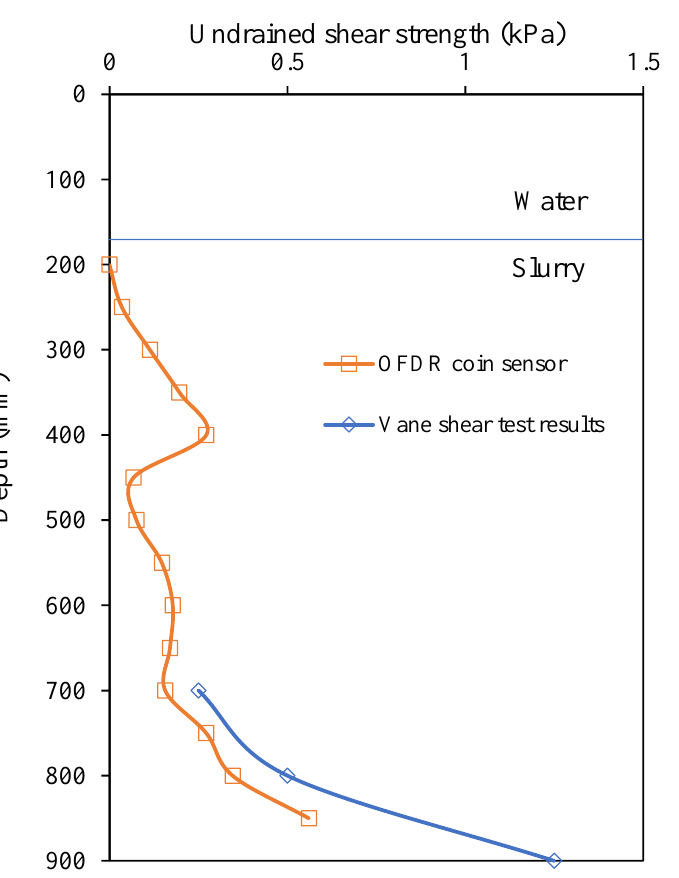
Figure 13. Undrained shear strength measured by the OFDR coin sensor and vane shear test.